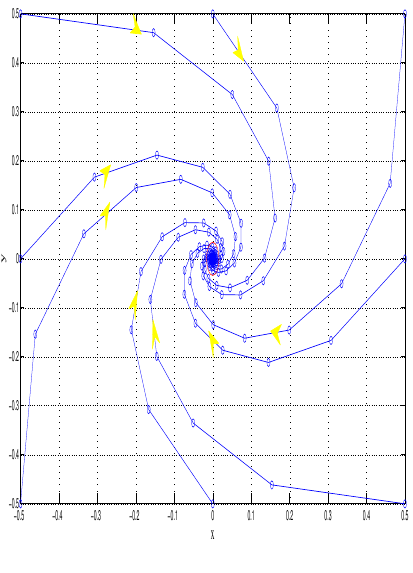
Figure 13. The numerical solutions generated by the NSFD scheme with h = 0 . 5 and t ∈ [0 , 1000] in Example 5.